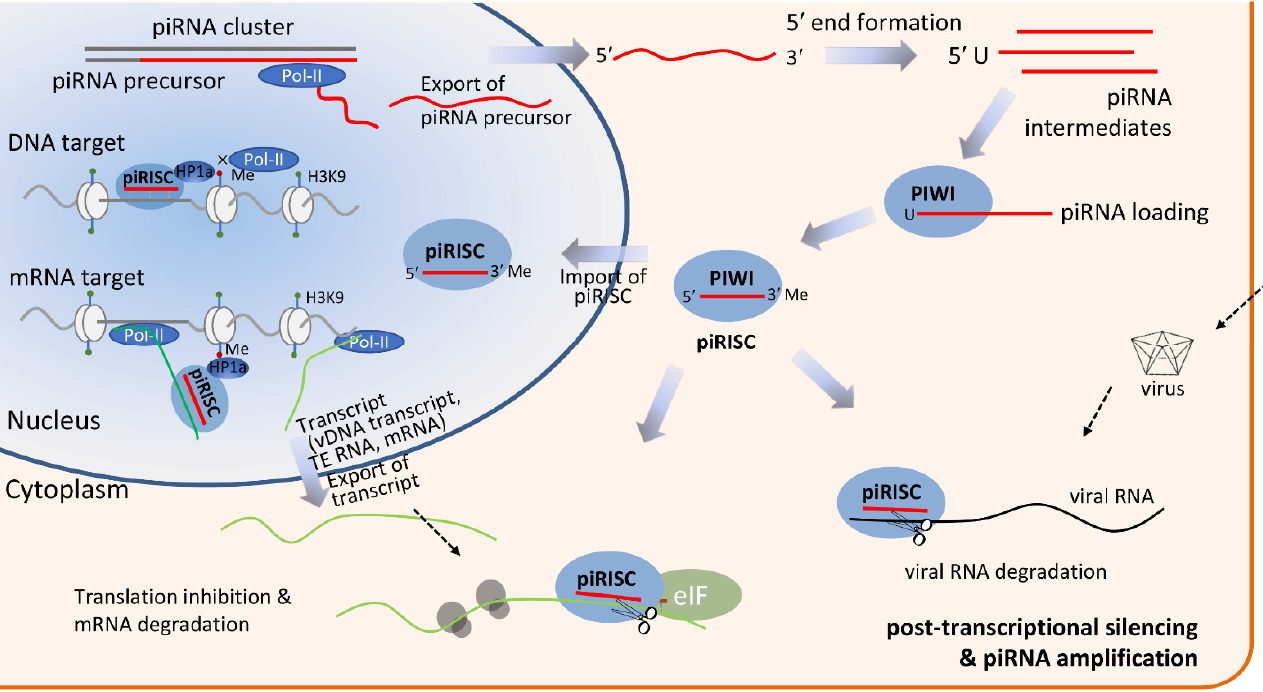
Figure 3. piRNA biogenesis and its functional roles in metazoans. In most cases, the piRNA pathway begins with transcription of piRNA clusters, which is mediated by RNA polymerase II (pol II), to generate the respective precursor piRNA (pre-piRNA) transcripts in the nucleus and drive them to cytoplasm where primary and second piRNA biogenesis takes place. The primary transcripts of piRNA clusters are shortened into piRNA intermediates and subsequently loaded onto PIWI proteins and trimmed from the 3 ′ end to the size of mature piRNAs and then 2 ′ -O-methylated. The mature piRNAs interact with PIWI proteins to form piRISC, which serves various functions in the nucleus and cytoplasm. piRISC is translocated to the nucleus and targets the nascent transcripts through sequence complementarity. Upon binding, PIWI recruits the epigenetic modifier heterochromatin protein 1 (HP1a) and histone methyltransferase (HMT) to a methyl group on unmethylated histone 3 lysine 9 (H3K9) to inhibit pol II transcription, effectively silencing transcription of the gene or TE. The piRNA pathway may also start with a transcript of a protein-coding gene, viral DNA (vDNA), or an invasive viral RNA in the cytoplasm in order to silence the transcript through the ping-pong amplification loop.